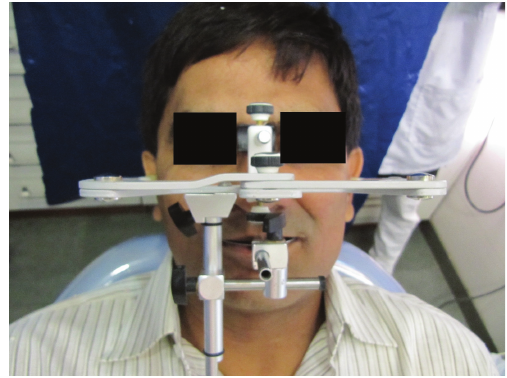
Figure 3: Facebow transfer.